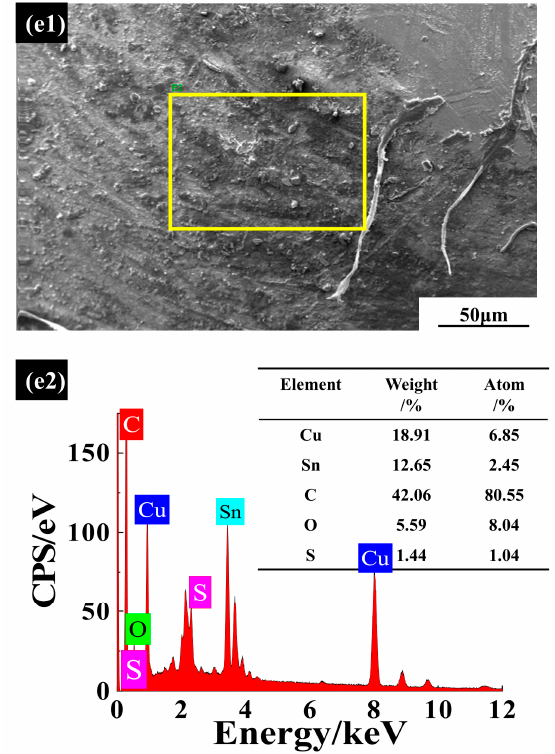
Figure 7. Micro-morphology of the contact surface in oil ( a1 – e1 ) and the corresponding EDS energy spectrum of magnified yellow areas ( a2 – e2 ) at the sliding speeds of ( a1 , a2 ) 24 mm/s, ( b1 , b2 ) 50 mm/s, ( c1 , c2 ) 76 mm/s, ( d1 , d2 ) 95 mm/s and ( e1 , e2 ) 119 mm/s. (The part circled by the yellow box is the analysis area of EDS energy spectrum).